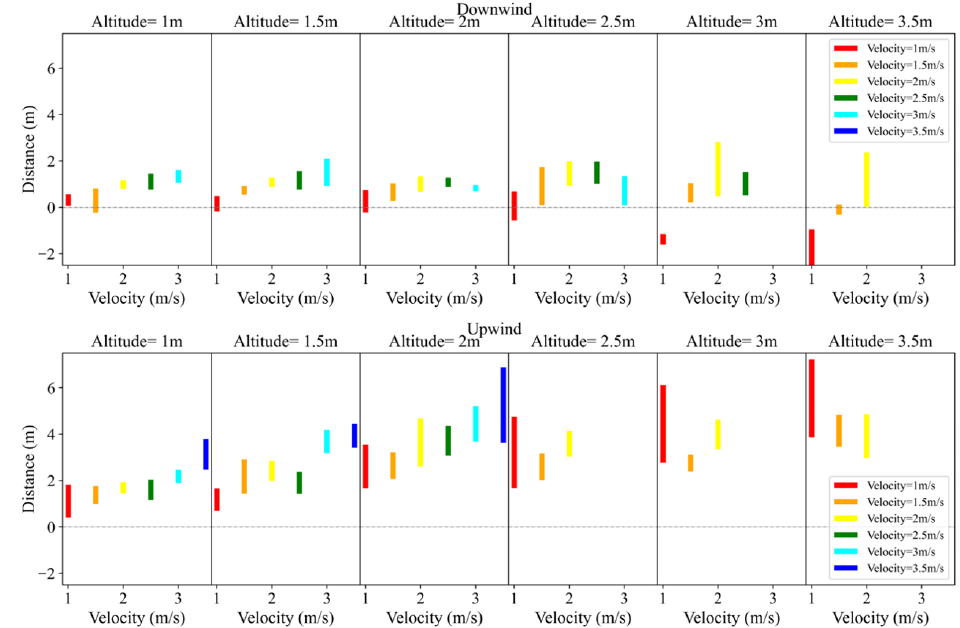
Figure 8. 95% confidence interval of wind - vortex distance at each flight, altitude, and speed.